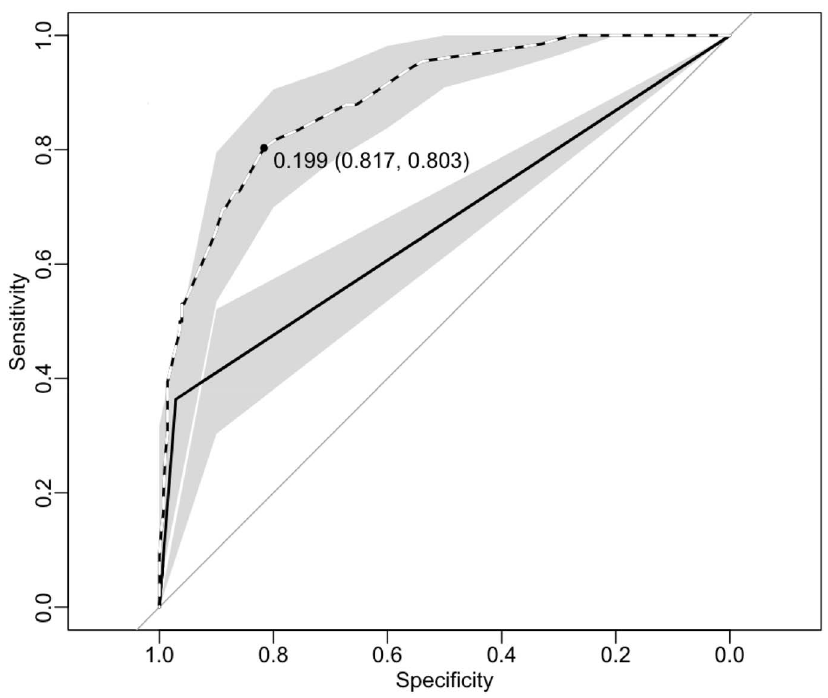
Figure 4. The receiver operating characteristics curve (ROC) showing the lowest cut-off probability with the highest specificity and sensitivity for the diagnostic/screening algorithm, this probability is used to adjust the case classification in figure 2. The Solid line represents DZM on its own at AUC= , 66%, the dotted line shows the model with DZM and the three predictors at AUC= , 88%.